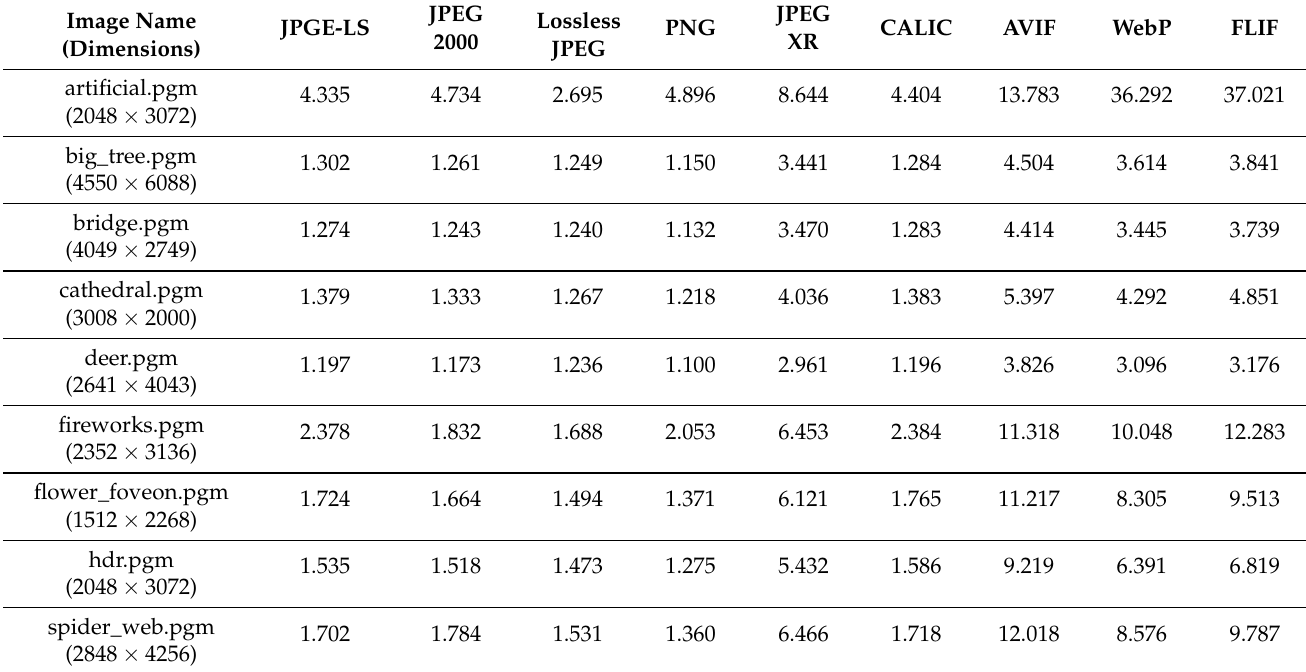
Table 8. Comparison of compression ratios for 16-bit RGB